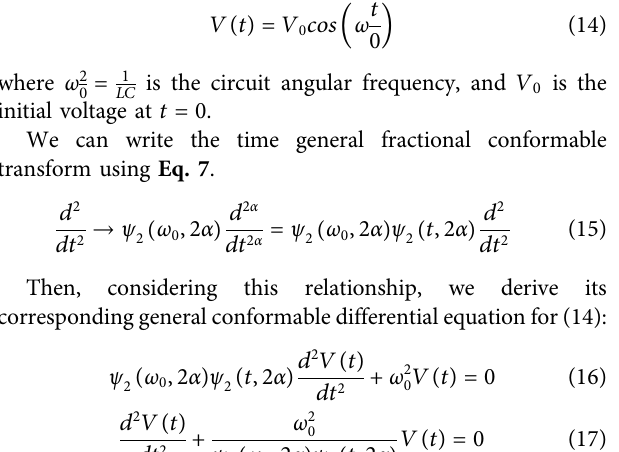
FIGURE 11 | Evolution of V ( t ) with α (cid:2) 0 .